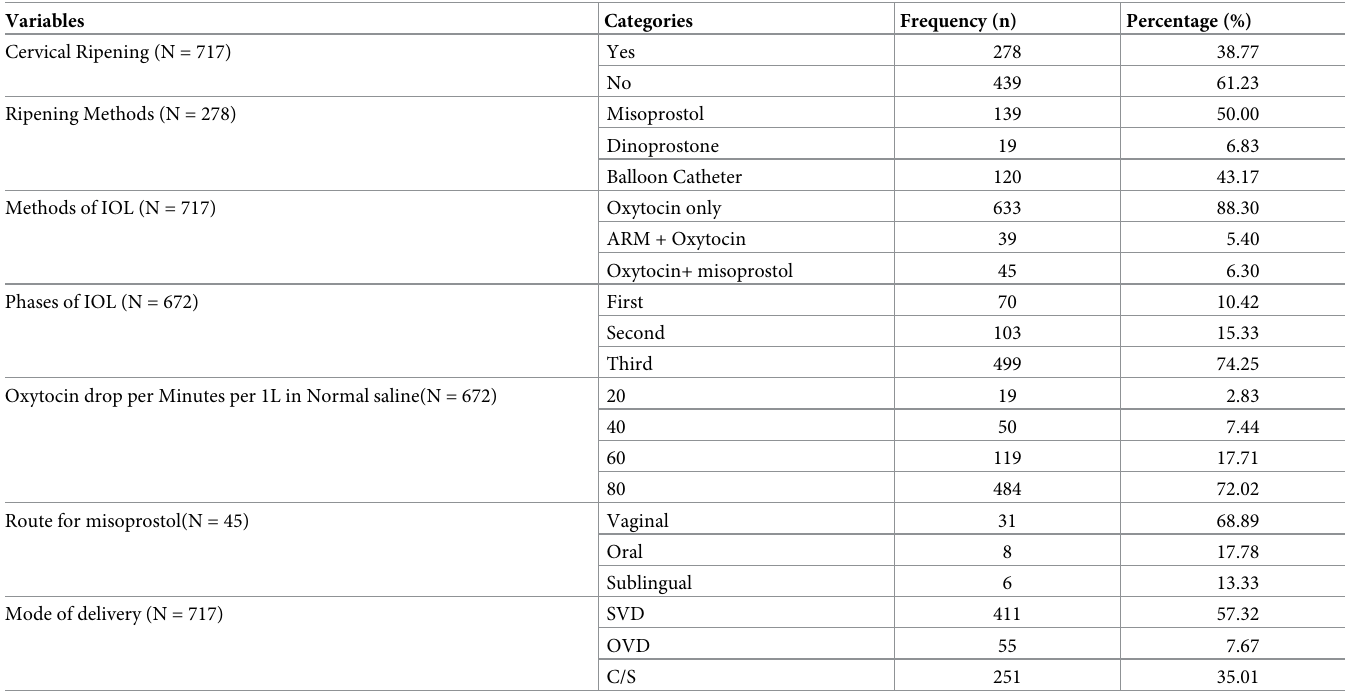
Table 2. Methods of induction of labor and mode of delivery among mothers who delivered after induction of labor in public Hospitals, Harari Regional State, East- ern Ethiopia,